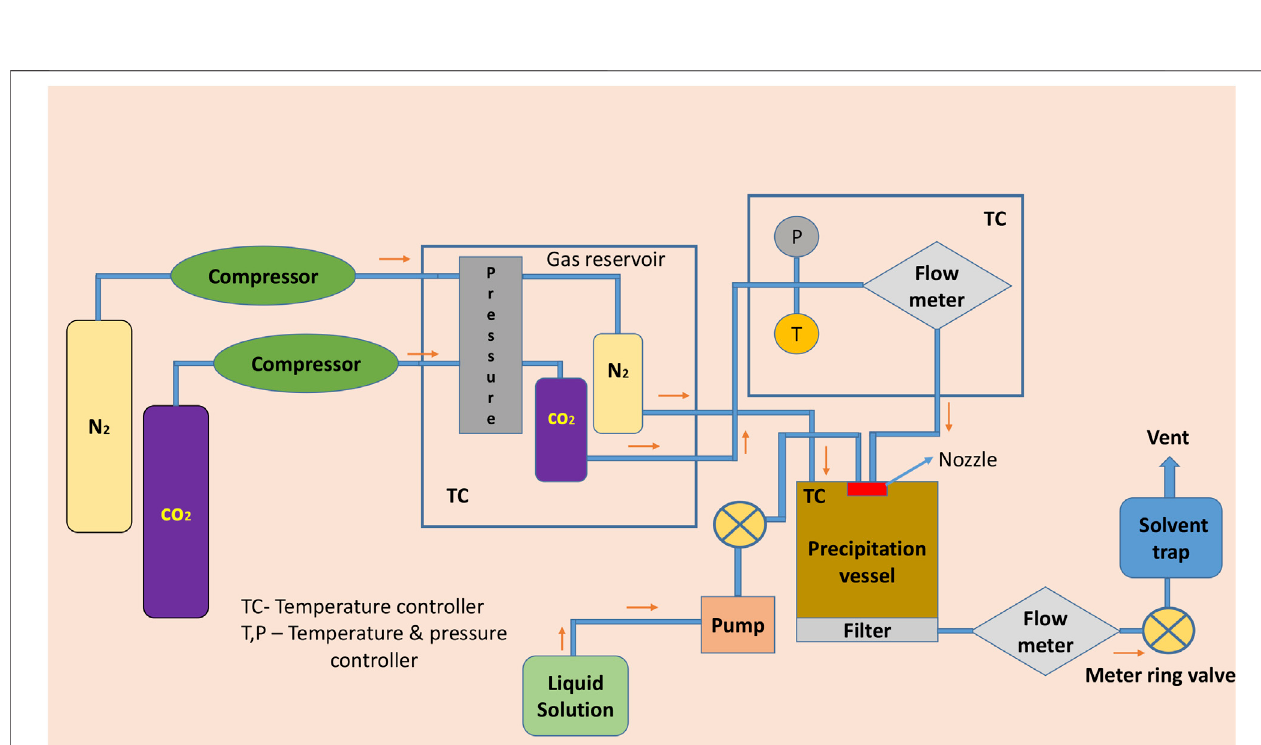
FIGURE 3 | Schematic diagram of supercritical atomization and anti-solvent crystallization and supercritical anti-solvent crystallization.